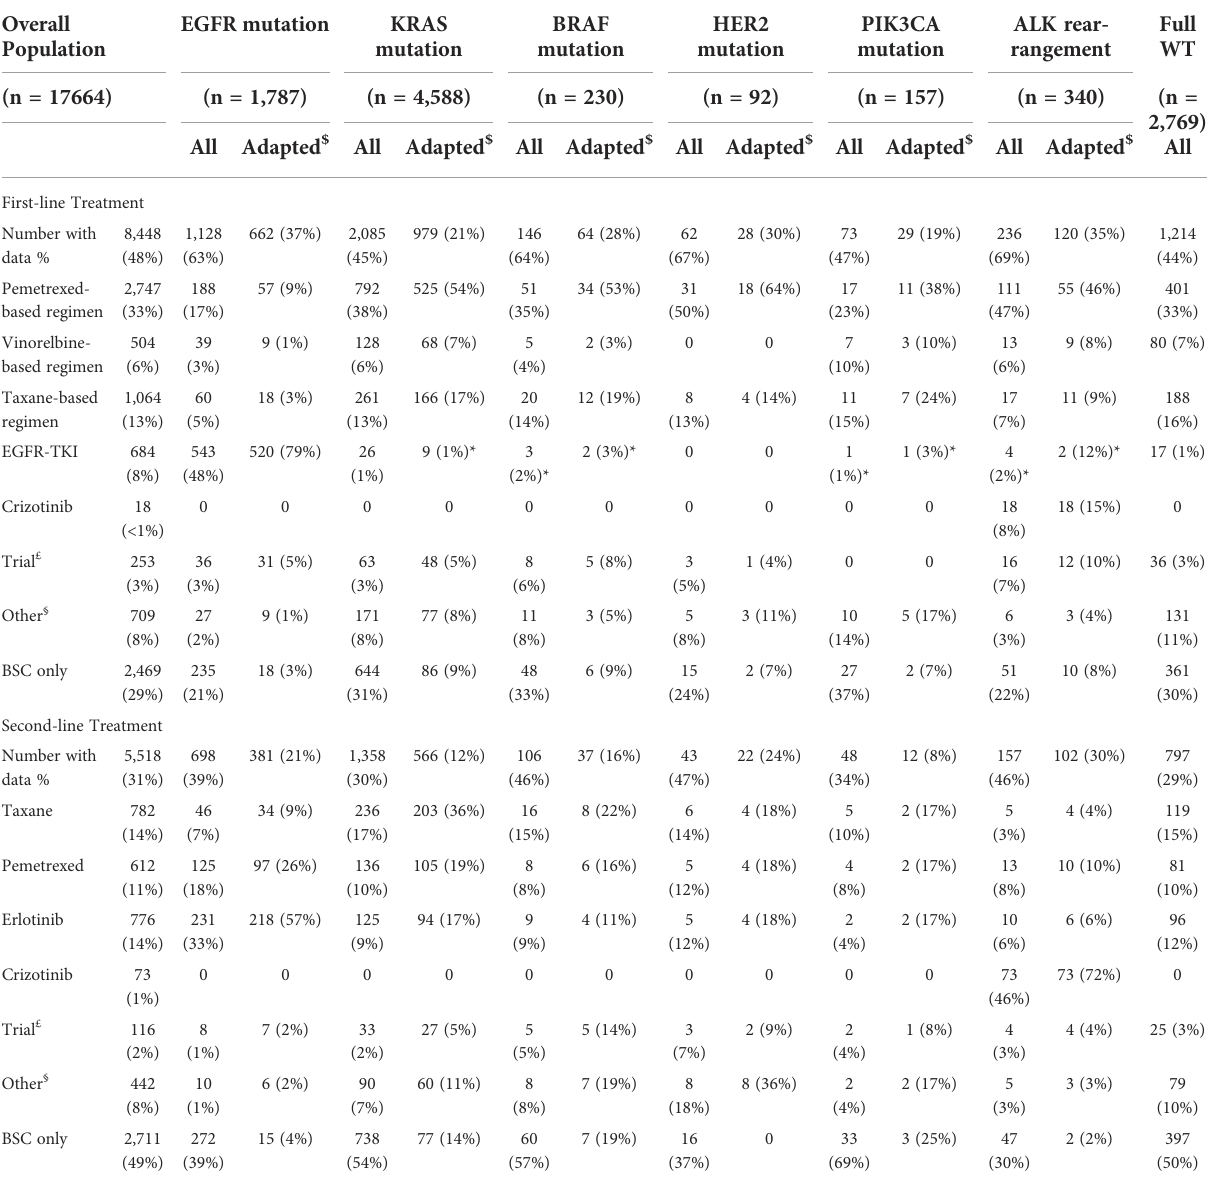
TABLE 3 Effects of fi rst-line and second-line treatments in NSCLC